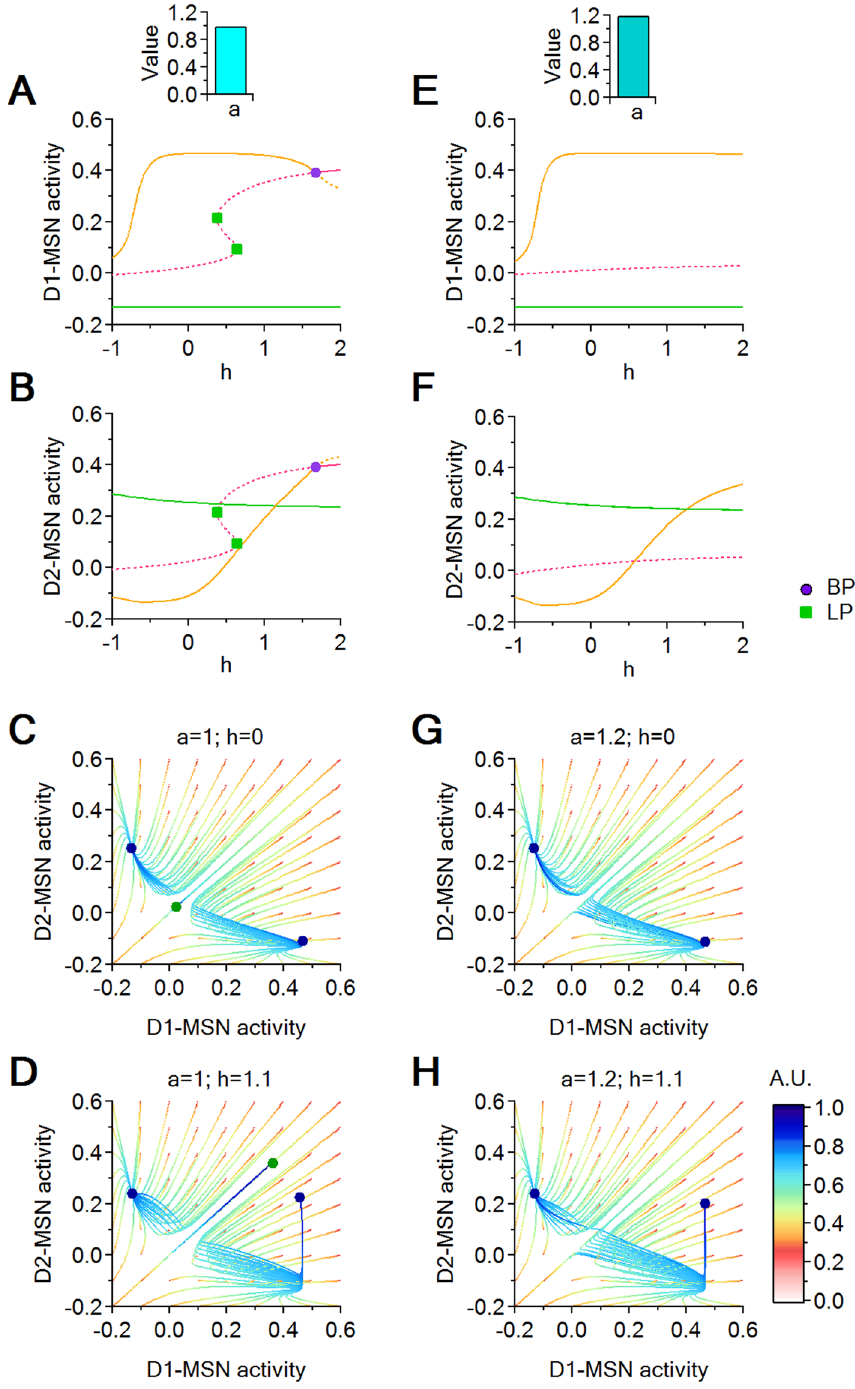
Figure 8. Dynamic transitions for a = 1 and a = 1.2. ( A , B ) Bifurcation diagrams showing the D1- and D2-MSN variable coordinates with respect to h , when a = 1. ( C , D ) Trajectories in a ( D 1, D 2) phase space slice for h = 0 and h = 1.1, when a = 1. ( E , F ) As in ( A , B ), for a = 1.2. ( G , H ) As in ( C , D ), for a = 1.2. Fixed parameters: